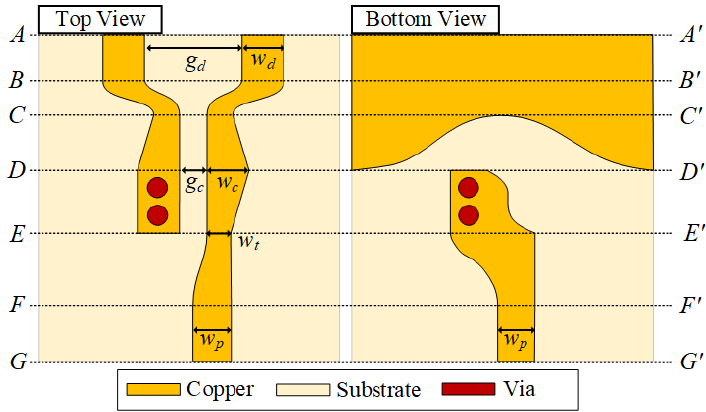
Figure 13. Top and bottom views of the proposed DL-to-PSL transition.